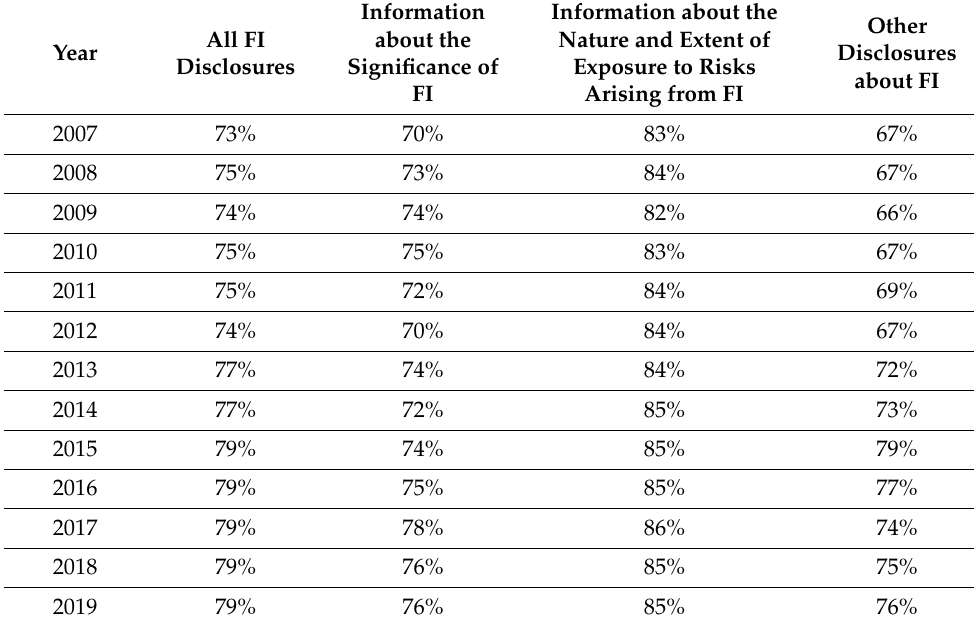
Table 9. The percentage of compliance with FI disclosure requirements across each